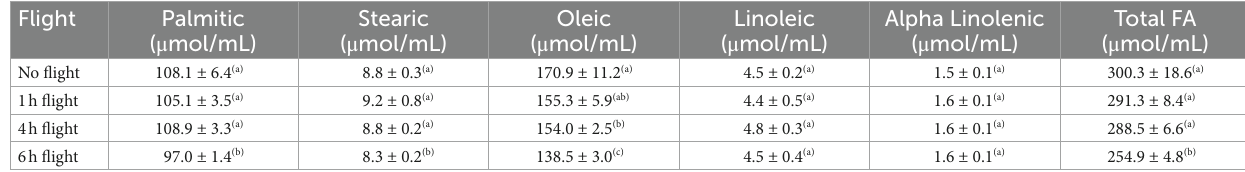
TABLE 3 Change in the concentration of essential and nonessential fatty acids in the fat body of 5- day old true armyworm moths as a function of flight duration under fall conditions.